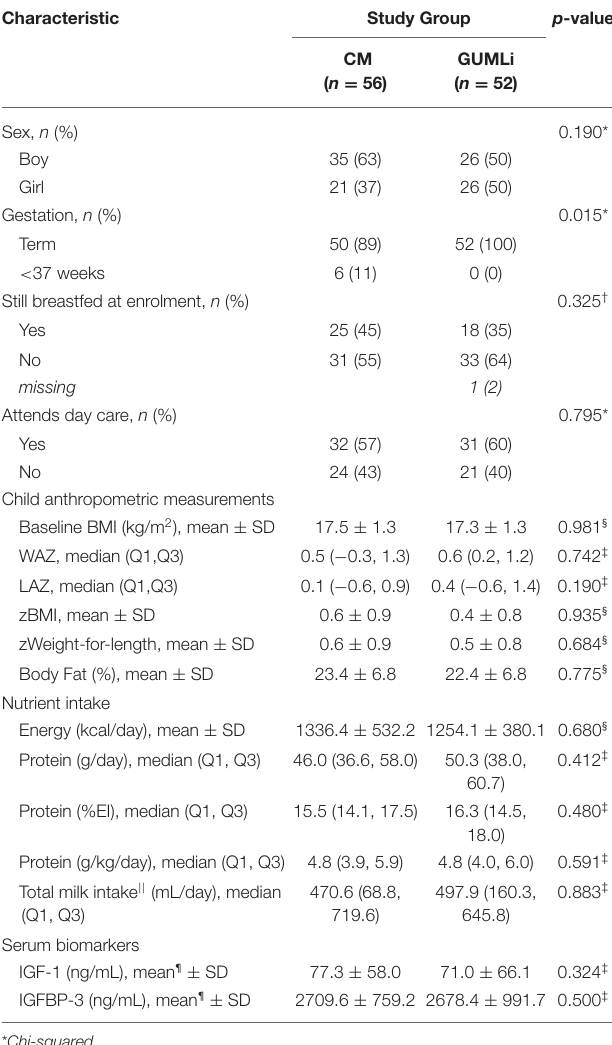
TABLE 1 | Birth and baseline characteristics of included Auckland participants ( n =